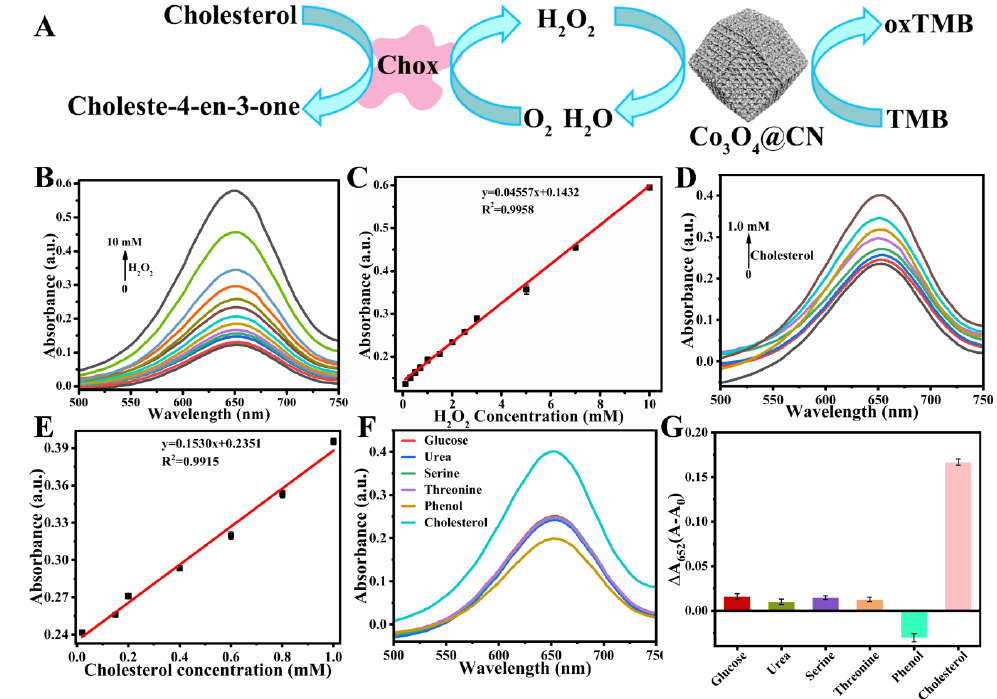
Figure 5. ( A ) Schematic diagram of Co 3 O 4 @CN-based cholesterol sensor. ( B ) The UV-visible absorption spectra of the reaction system after the addition of different concentrations of H 2 O 2 . ( C ) Linear relationship between absorbance at 652 nm of reaction system and H 2 O 2 concentration. ( D ) The UV-visible absorption spectra of the reaction system after the addition of different concentrations of cholesterol. ( E ) Linear relationship between the absorbance at 652 nm of reaction system and the cholesterol concentration. Selective analysis of the cholesterol sensor. ( F ) The UV-visible absorption spectra of the reaction system after the addition of the interfering molecules. ( G ) The variation (ΔA) of absorbance at 652 nm in the reaction system after the addition of the different interfering molecules. A 0 and A indicate the absorbance of the reaction system at 652 nm before and after the addition of the interfering molecules, respectively.